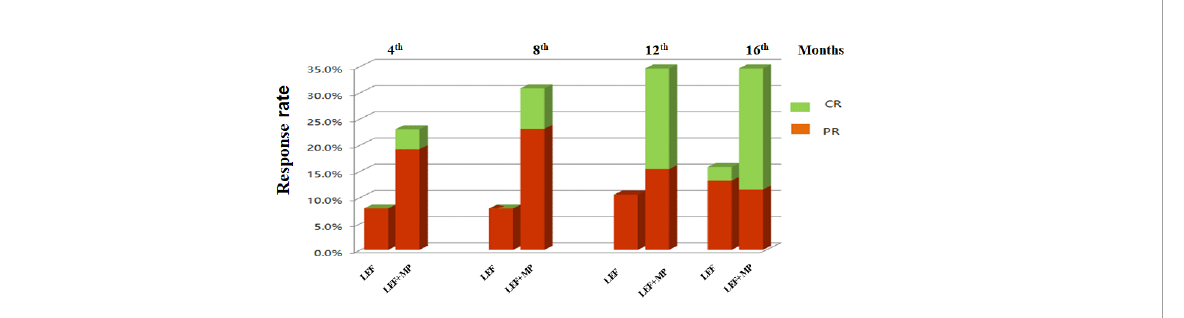
FIGURE 2 Remission rates (CR + PR, CR, PR) in the LEF group and the LEF+MP group over time. Percentage of complete (green) and partial (red) remissions in the two groups.CR, complete remission; PR, partial